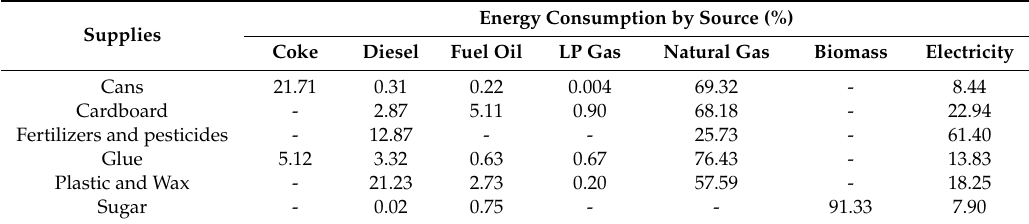
Table 2. Energy consumption for manufacturing supplies used in the product